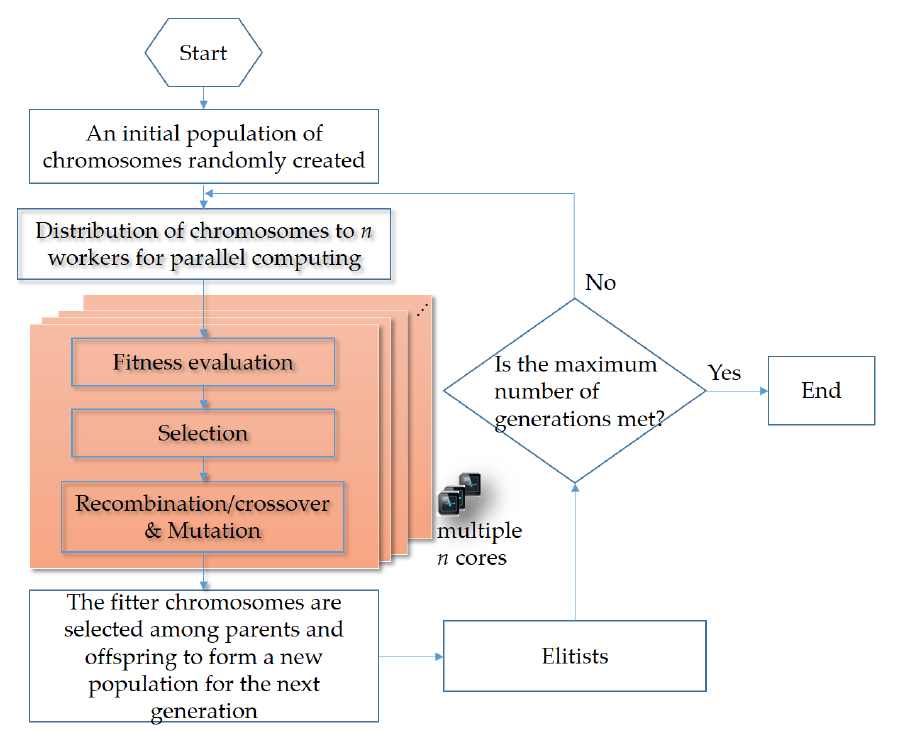
Figure 3. A workflow of the parallel computing accelerated GA used to solve Equation (2) for load recognition in the NIALM in this paper, where the evolutionary cycle is parallelized.